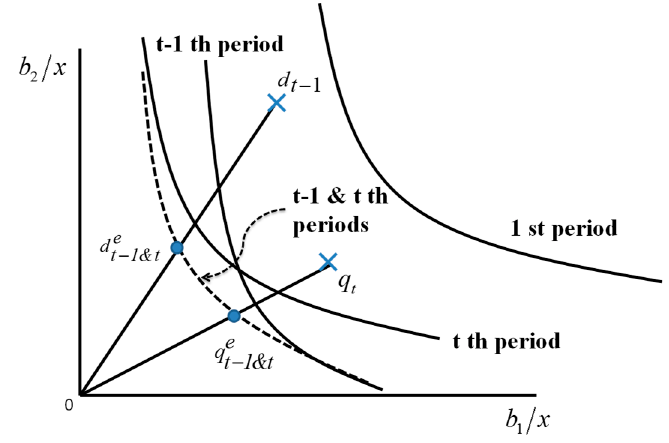
Figure 5. Frontier crossover under managerial disposability.